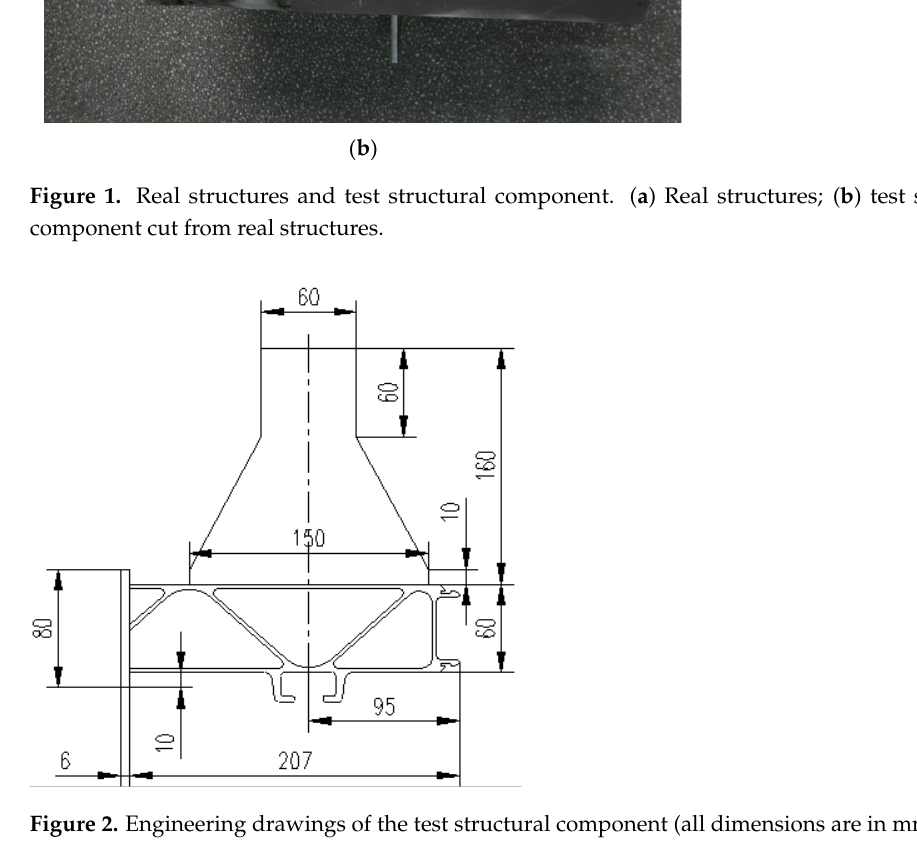
Figure 2. Engineering drawings of the test structural component (all dimensions are in mm).